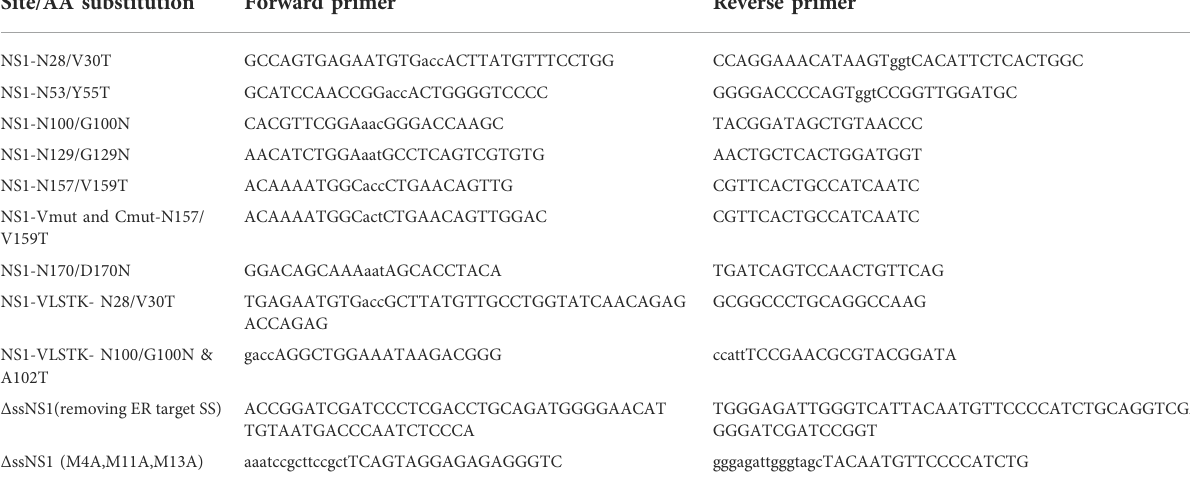
TABLE 1 Primers used to make NS1